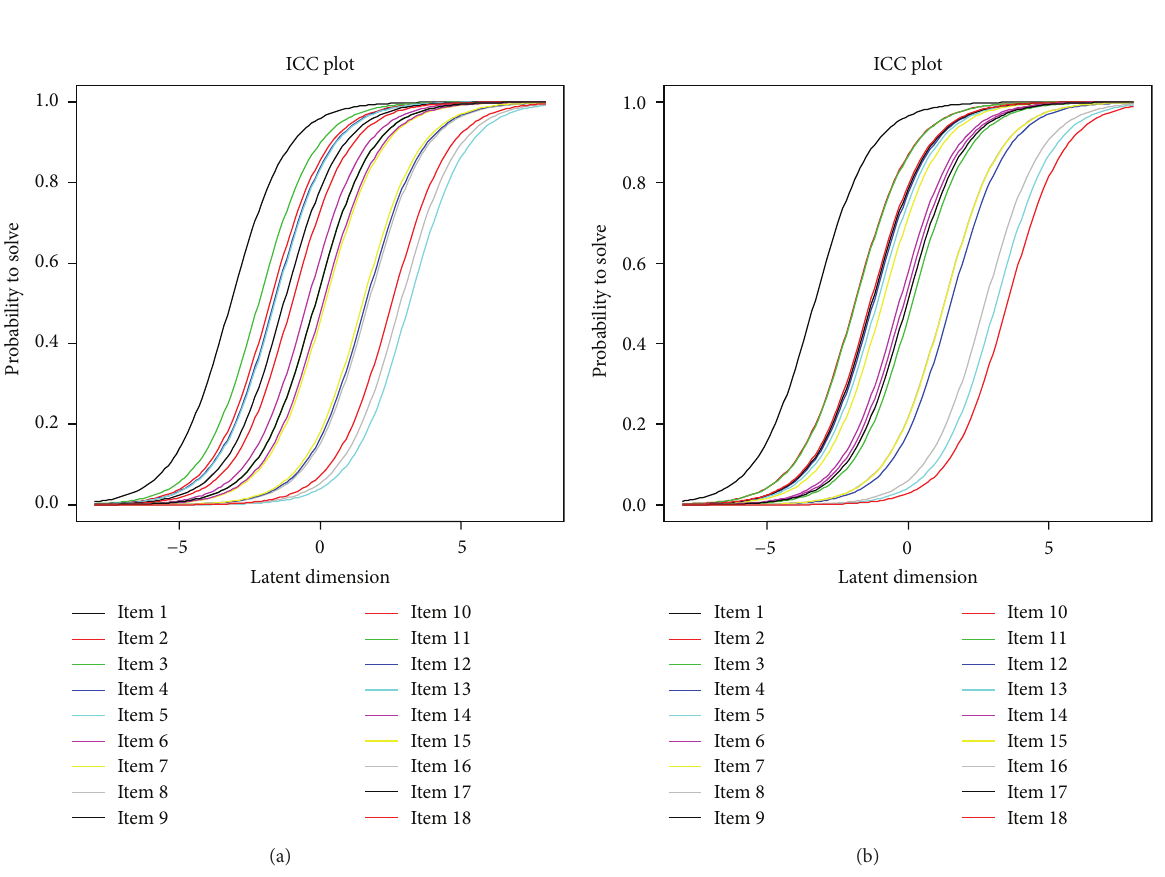
Figure 3: Item characteristic curves for Rasch model check for the districts of Tororo (a) and Busia